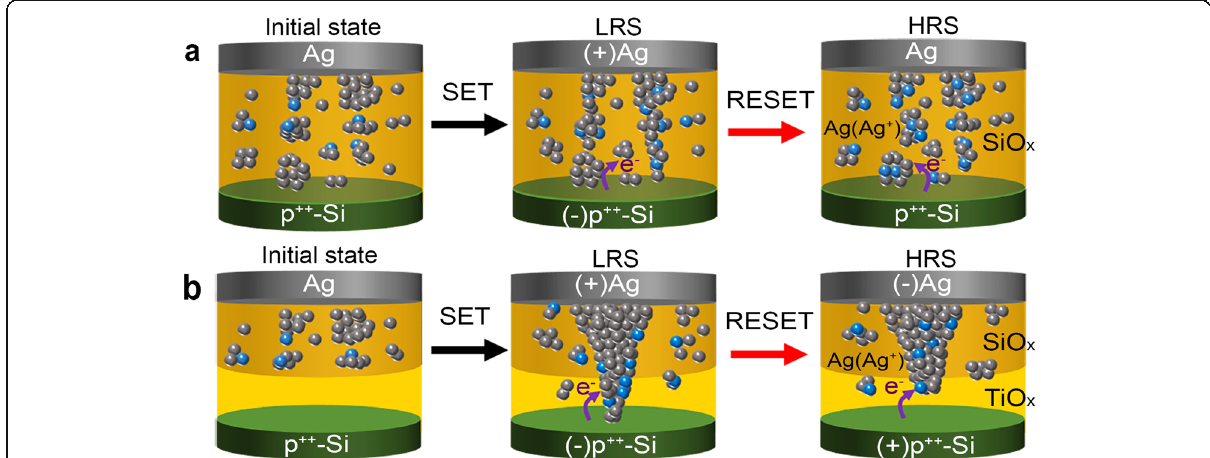
Fig. 4 Schematic diagram of the physical model for switching behavior. a Ag/SiO x :Ag/p ++ -Si memristor device; b Ag/SiO x :Ag/TiO x /p ++ -Si memristor